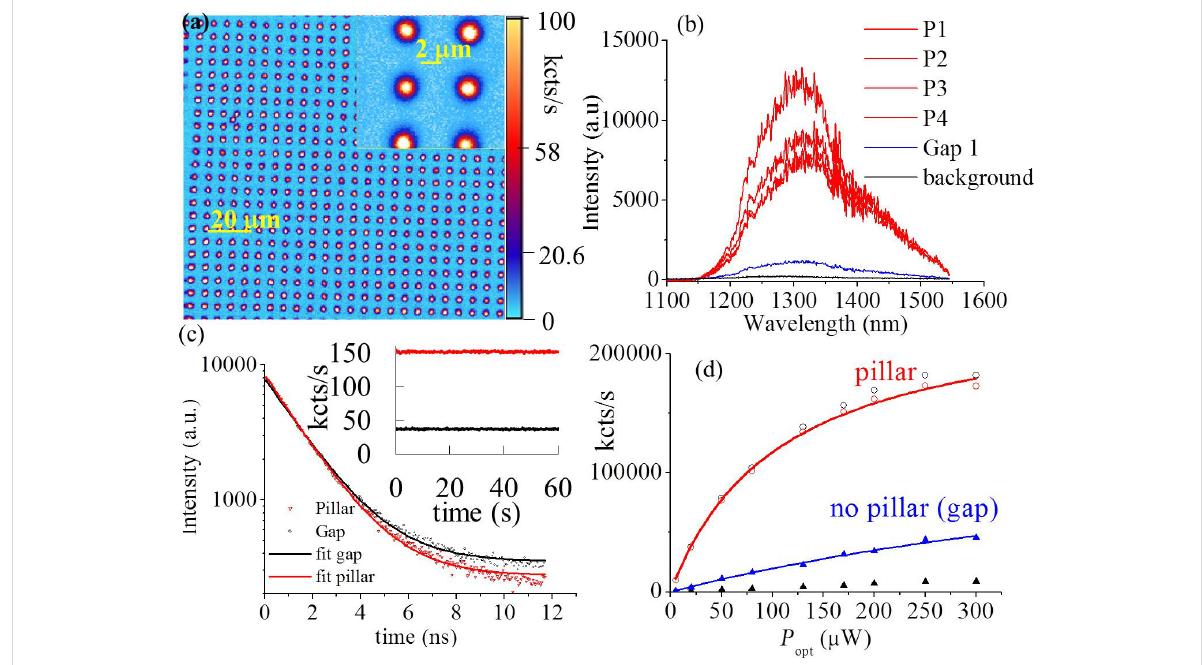
Figure 6: Confocal image and zoom image of a 10 × 10 µm 2 N C V Si fluorescent micropillars array excited by a 980 nm laser, recorded using InGaAs single-photon detectors. An Olympus 0.85 NA infrared objective was used. (a) Sample 3 excited with 100 µW laser power, with only 10% collection emission sent to the single-photon detectors for imaging and integrated count rate, using a LP at 1319 nm and a BP at 1350 ± 50 nm. (b) PL for a few single pillars measured with 90% emission collected by a spectrometer with a InGaAs CCD camera using a LP at 1100 nm. The PL of the pillars is compared with emission from the gap and from the background. (c) Lifetime measurement of a single pillar emission using a LP at 1319 nm and of the emission from the gap. Inset: Photostability of a single pillar emission using a BP at 1350 ± 50 nm and an exaction power of 10.5 μ W compared to the gap region. An enhancement by a factor of four is measured. (d) The saturation count rate of one pillar and the gap region, showing the pillar satura- tion at 108 μ W optical power, while the gap region is saturated at 674 μ W. The saturation curve is corrected for the background indicated by the black